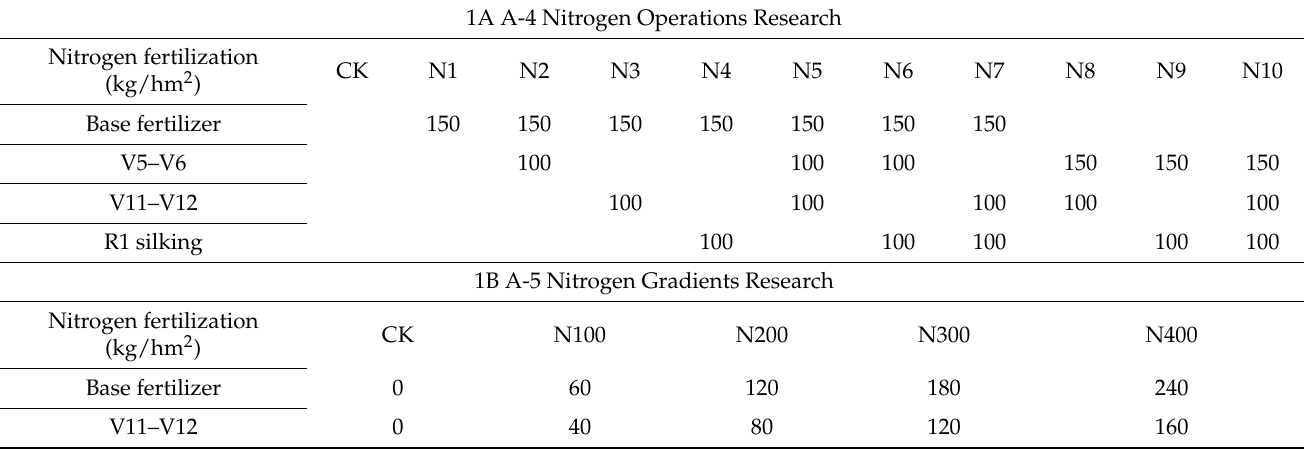
Table 1. Nitrogen treatment application